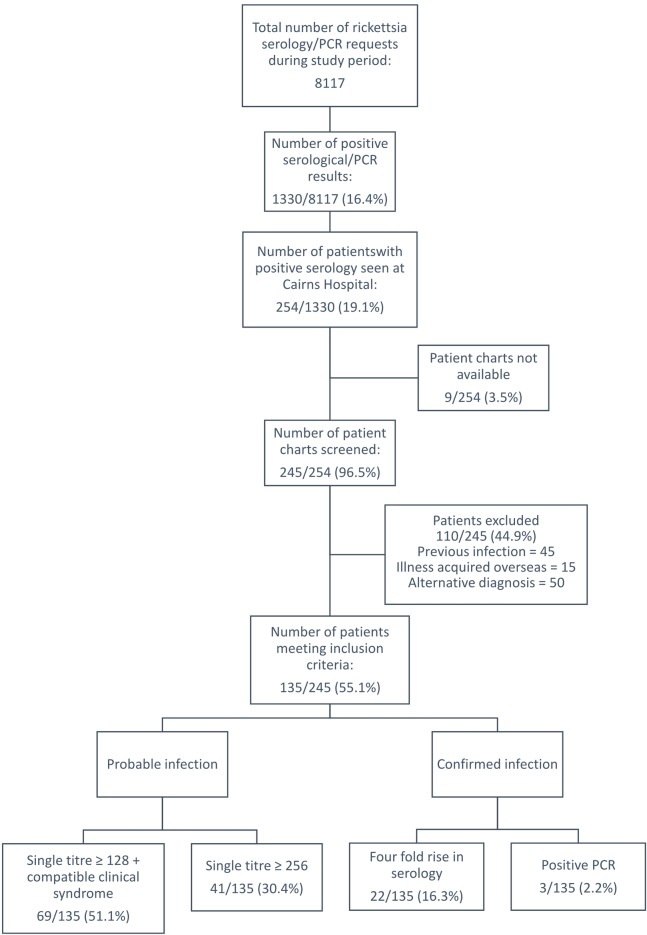
Data collection.